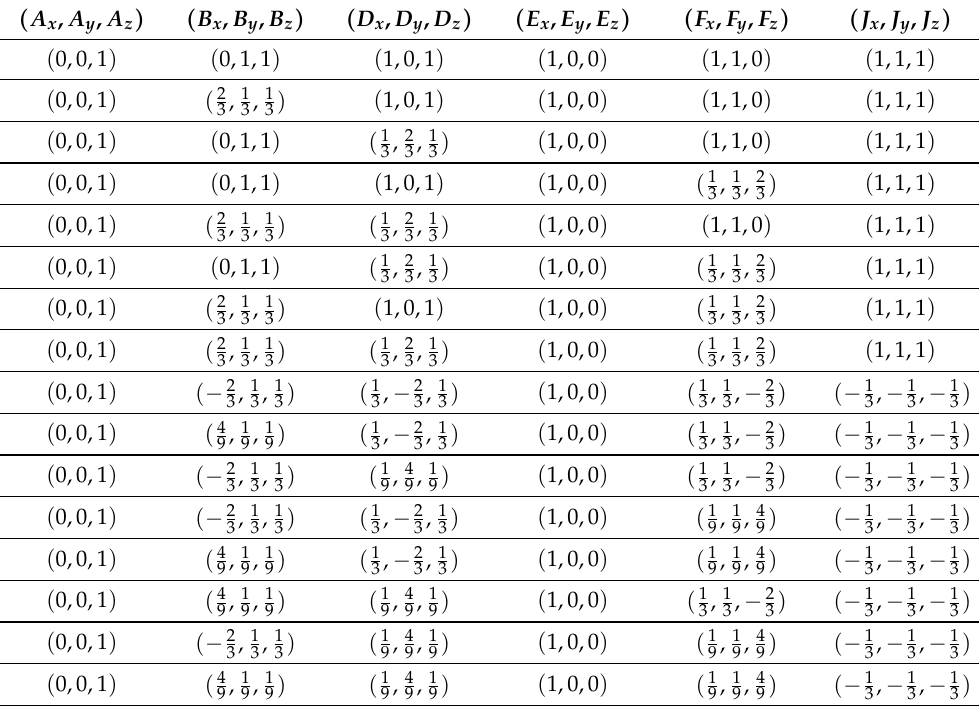
Table 2. Representatives of non-congruent realizations of the rigid cube C R